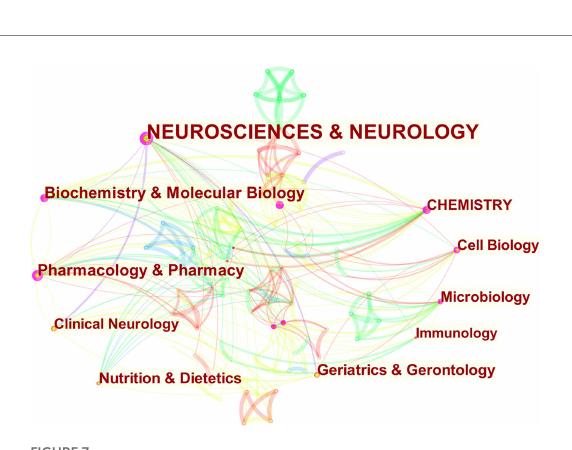
FIGURE 7 The visualization of co-occurring subject categories for MGBA in AD. The size of the nodes in the graph represents the number of publications of the institution, and the thickness of the lines between nodes represents the strength of the relationship. The different colors of nodes and connection lines represent different years (for instance, purple represents 2013–2014, green represents 2017–2018, and red represents